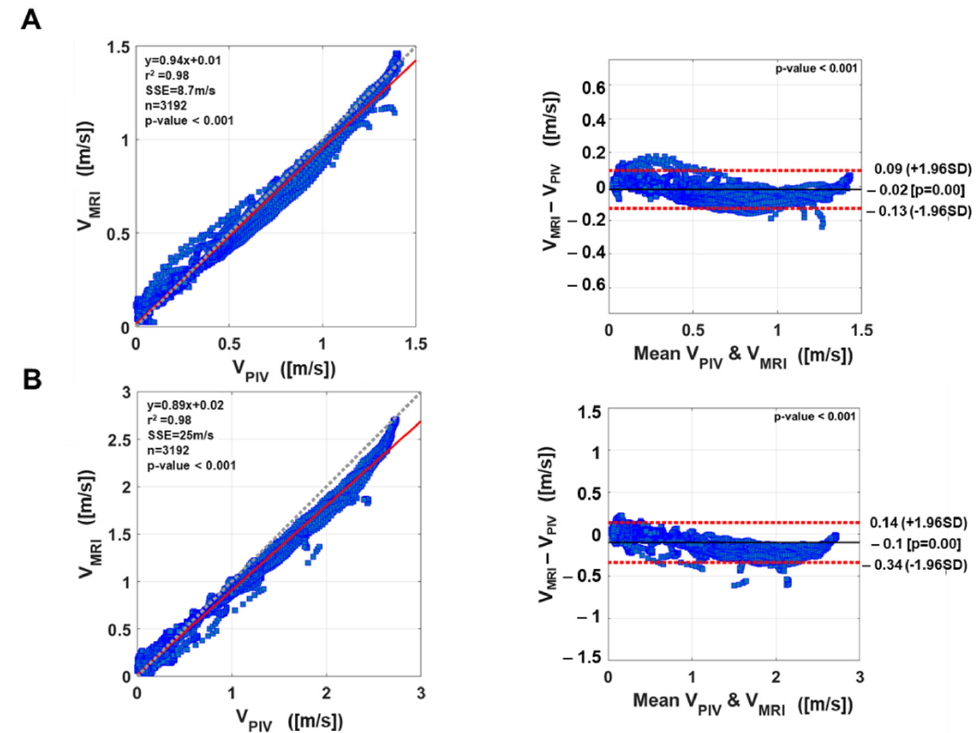
Figure 3. Bland–Altman plot of the velocity measurements. ( A ) Velocity comparison at the flow rate of 10 L/min. ( B ) Velocity comparison at the flow rate of 20 L/min. Solid red line indicates the slope of the linear regression. Gray dashed line indicates the slope of unity. Black solid line and red dashed line are mean ± 1.96SD.